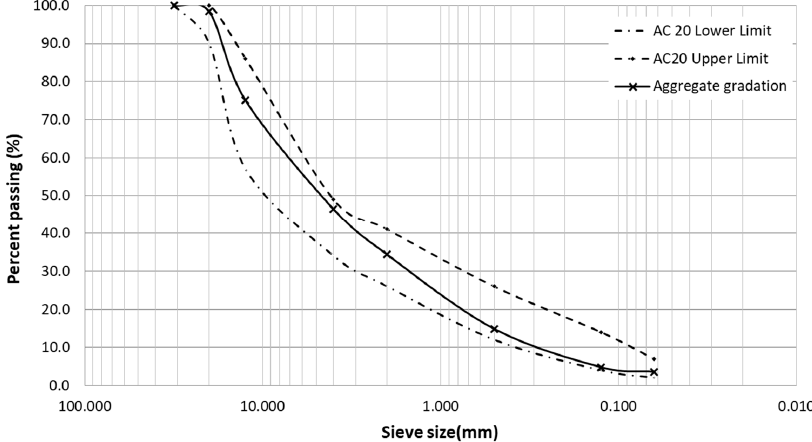
Figure 2. Aggregate gradation of the AC 20 mixture.